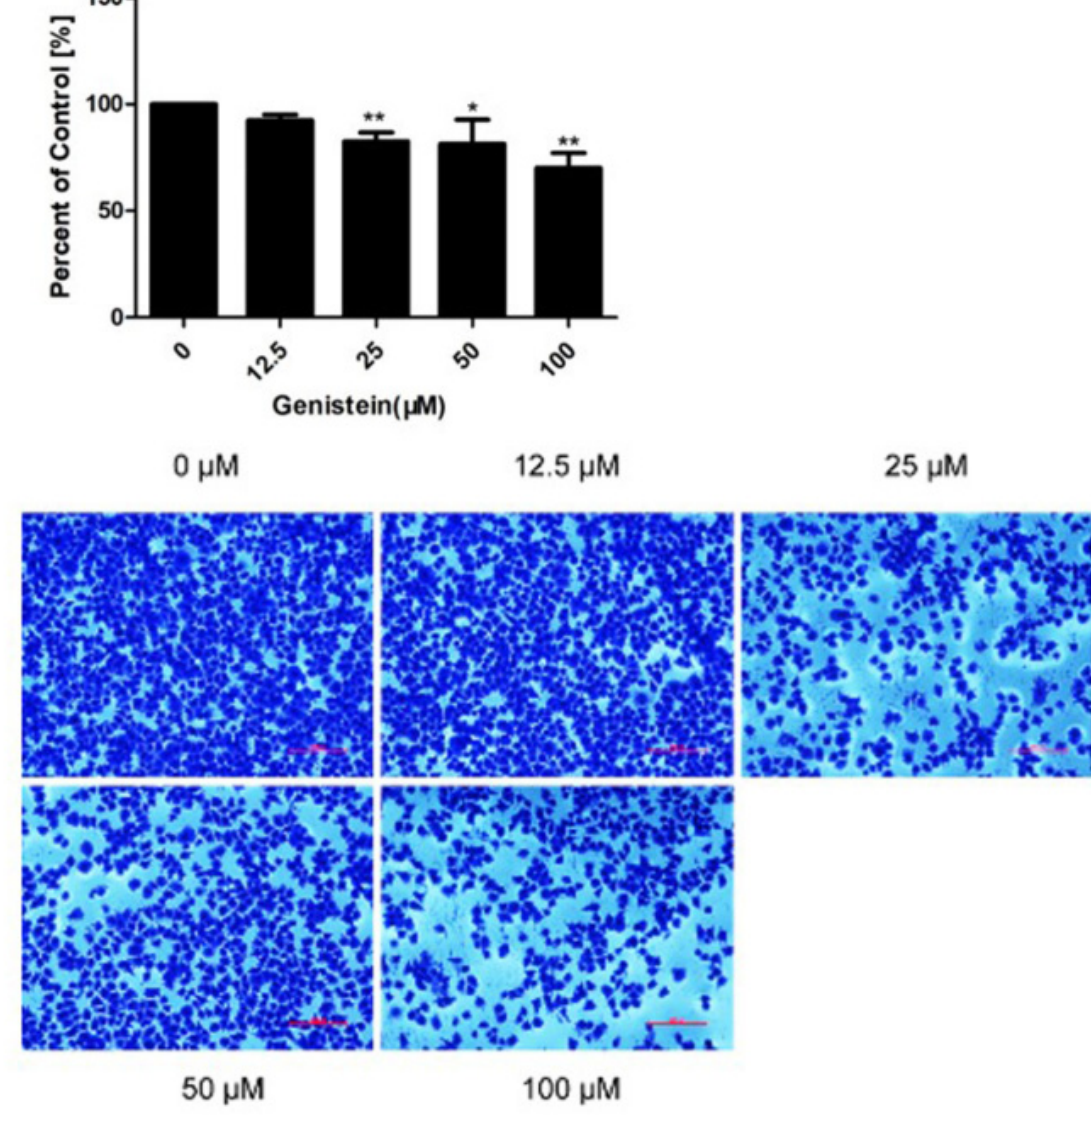
Figure 7. Effects of genistein on HeLa cell adhesion. Cells were grown in the presence of different doses of genistein for 24 h, and reseeded for 3 h. Adherent cells were then fixed by PFA (Paraformaldehyde) and stained with crystal violet solution. Absorbance readings were detected at OD570 nm by microplate reader. ( A ). Percentage of adhesion was then calculated based on the OD value of the adhered cells in the genistein-treated group (compared to control values (100%)). The experiment was performed three times independently, and data shown are the average of all three replicates. ( B ). Representative images from the three independent experiments. ** p < 0.01 vs. DMSO control; * p < 0.05 vs. DMSO control. Scale bar: 200 μ m.